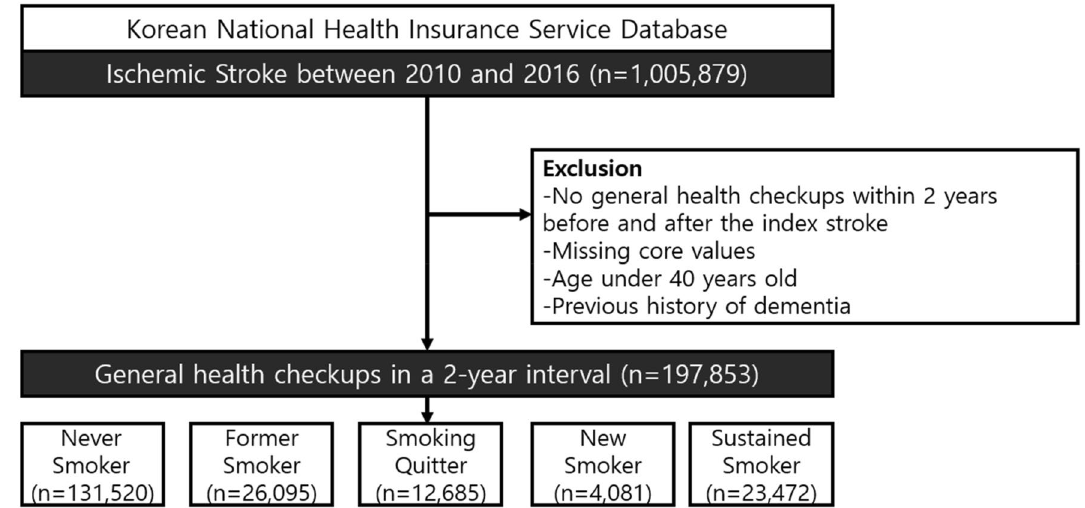
Figure 1. Flowchart of the selection of study